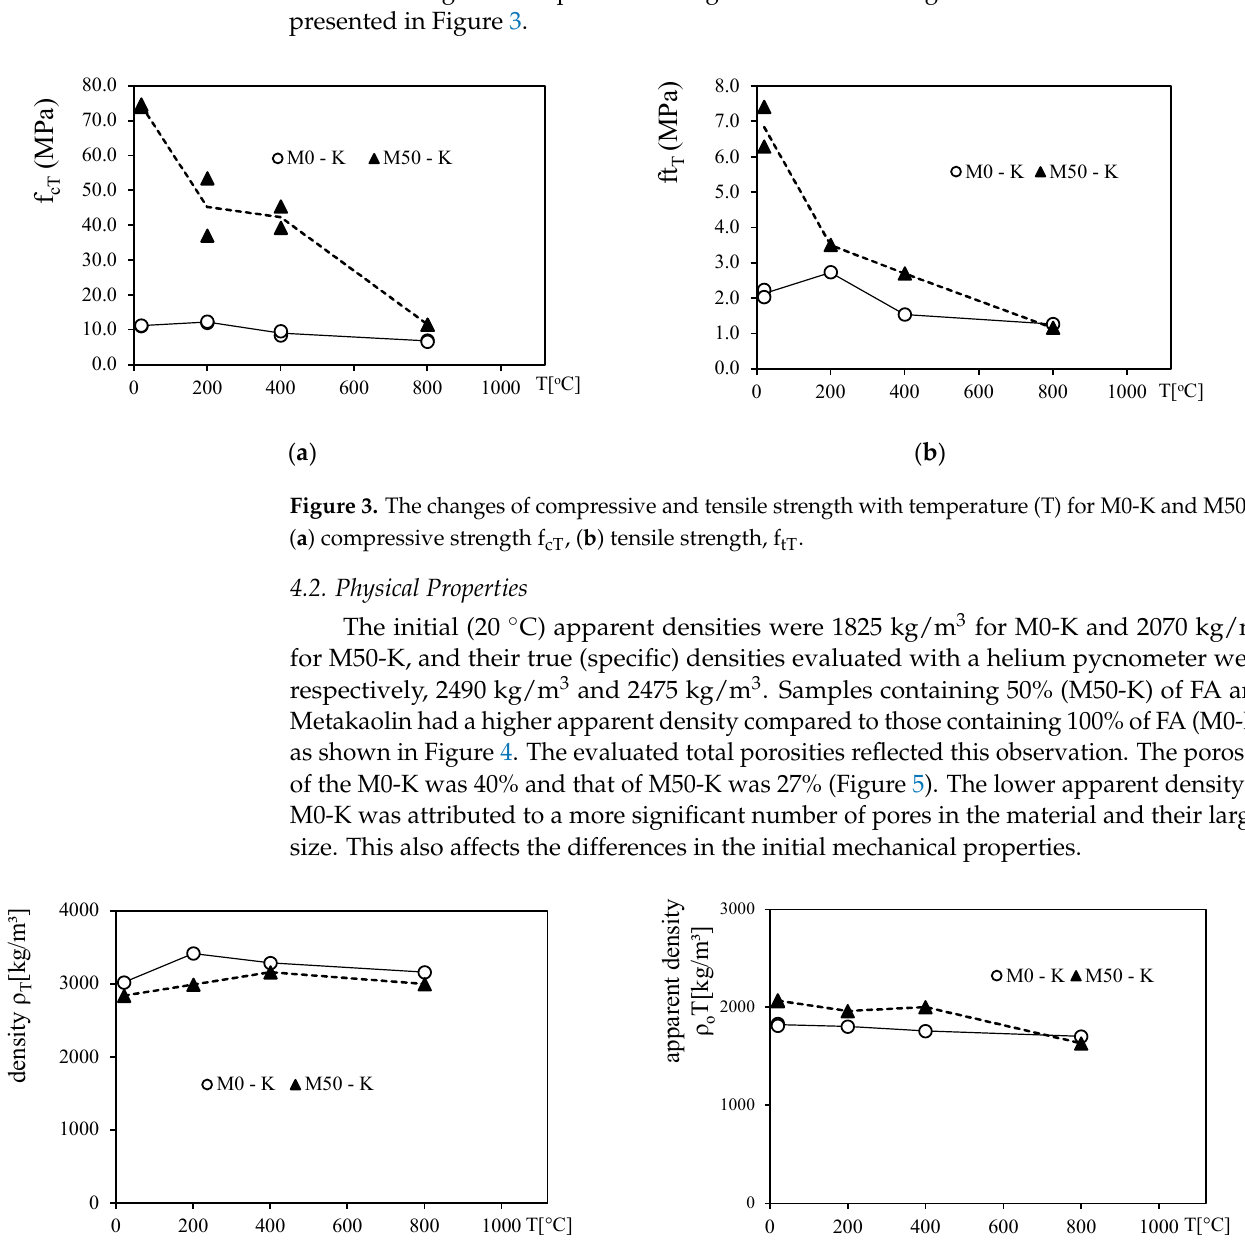
( a ) ( b ) Figure 5. ( a ) Ultrasound Pulse Velocity (UPV—V T ) and ( b ) porosity (P) with temperature. After high temperature exposure, the apparent density of the samples slightly de- creased due to the drying process and changes in the matrix. Once exposed to high tem- peratures, the components of the samples, such as aggregate, became dry. The moisture contained in the material was gradually removed through heating. Furthermore, heating did not significantly affect the change in density. The physically bound water was entirely evaporated, and the hydroxyl groups were removed at high temperatures. Some sources showed that the dihydroxylation process begins at 250 °C and continues up to 600 °C [10], which causes the geopolymer binder to shrink. For the M0-K, an increase in density after exposure to 200 °C was observed, while for the M50-K, density increased to 400 °C. This is related to the continuous geopolymeriza- tion process under elevated temperature; the mortar behaves similarly to an autoclaving mortar, with binder connections developing and strengthening. This was confirmed by the increase in tensile strength and applies more to a matrix without GGBSF. Another insignificant drop in density over 400 °C was related to the cracking of the matrix. The density ((cid:2025)) and the apparent density ((cid:2025) (cid:2868) ) values enabled the total porosity (P) to be determined. The variation in total porosity P with increasing temperature is pre- sented in Figure 5. The M0-K presents an increase in porosity between 20 °C and 200 °C. In this temperature range, the porosity remained stable (47%) from 200 °C up to 800 °C. On the other hand, for the M50-K, a slight increase in porosity from 20 °C (27%) to 800 °C (45%) was observed. The stable porosity level in the entire range of tested temperatures ensured constant thermal insulation parameters with increasing temperature, which is extremely important in cases of fire protection or fire-resistant material. Therefore, the